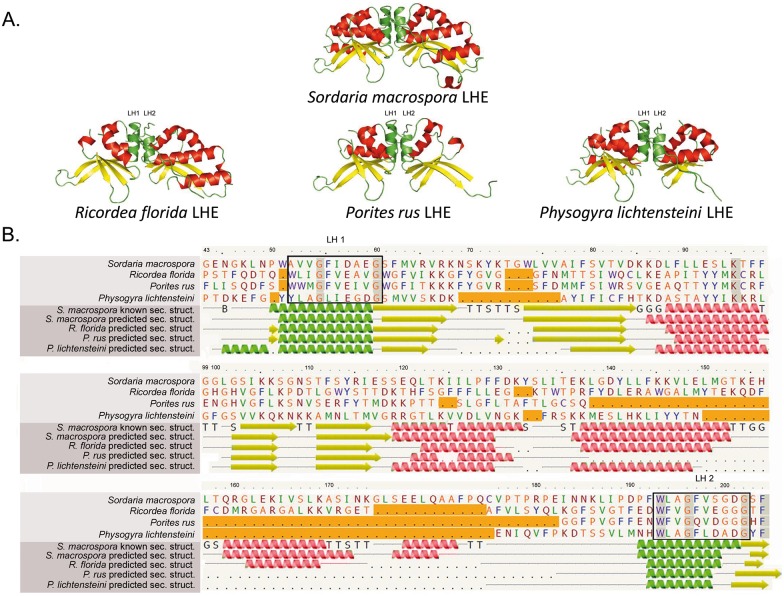
Predicted secondary structures and alignment of LAGLIDADG Homing Endonucleases (LHEs) found in Corallimorpharia and Scleractinia.(A) The experimentally validated LHE structure of the fungus S. macrospora shows the core elements being characteristic for canonical homing endonucleases. The predicted models of the LHEs found in R. florida (Corallimorpharia), P. rus (complex Scleractinia) and P. lichtensteini (robust Scleractinia) follow the general arrangement of helices, sheets and coils as in S. macrospora. The catalytic LAGLIDADG structures are represented by green helices (LH1 and LH2); red helices and yellow arrows depict the core α helices and the β sheets, respectively. (B) Alignment of the LHE based on residue similarity and secondary structure. The upper rows display the LHE amino acid sequences with orange and gray boxes representing deletions relative to S. macrospora and identical residues in the alignment, respectively. Lower rows show the known LHE structure of S. macrospora and the predicted secondary structures of the LHE analyzed. B, T, S and G in the S. macrospora row represent residues in isolated β-bridge, hydrogen bonded turn, bend and 3-turn helix (310 helix), respectively.